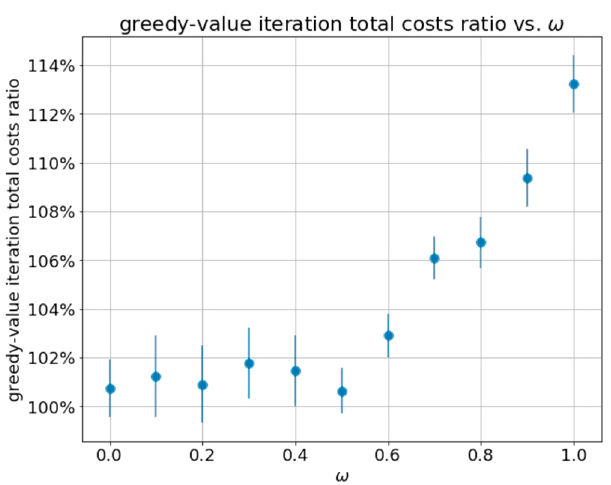
Figure 5. Ratio between total costs obtained by greedy and value iteration methods obtained over all patients for varying ω values, for the following set parameters: k = 6, C FN = 100, C FP = 50.